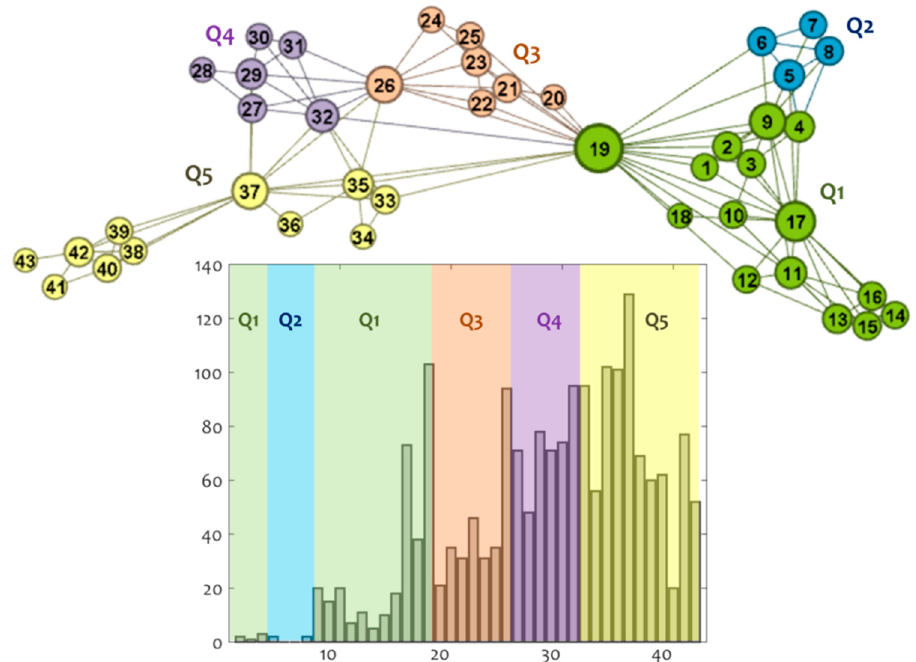
Figure 4. Division of the infection curve visibility graph ( G V ) associated with the Greek COVID-19 into five communities ( Q 1 : Q 5 ) based on the modularity optimization algorithm of [25].